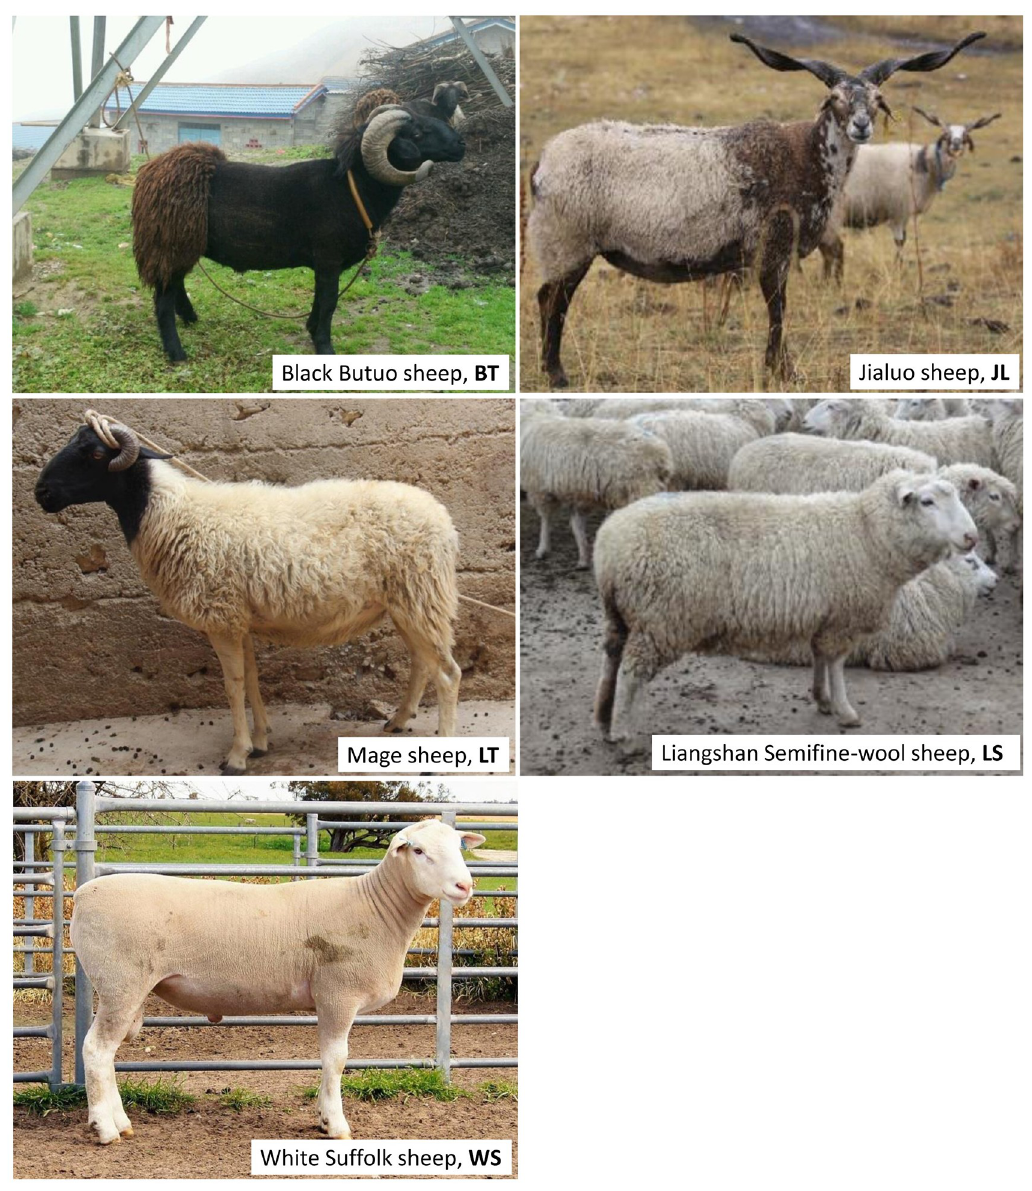
Fig 1. The five sheep breeds in Sichuan